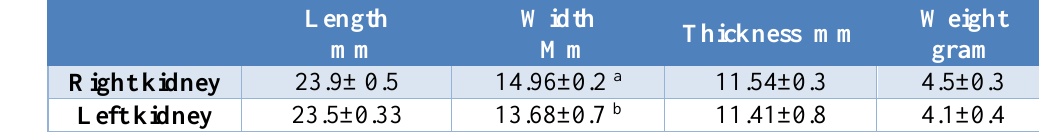
Table, 1: Length, width, thickness (mm) and weight (gram) of the right and left kidneys of male guinea pig.